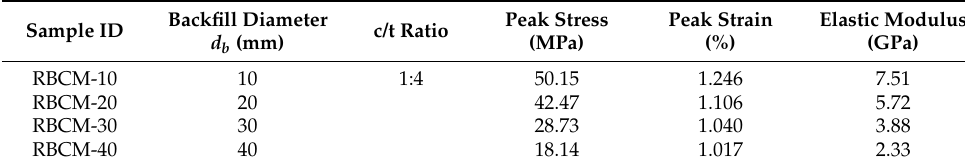
Table 1. UCS and elastic modulus of different kinds of